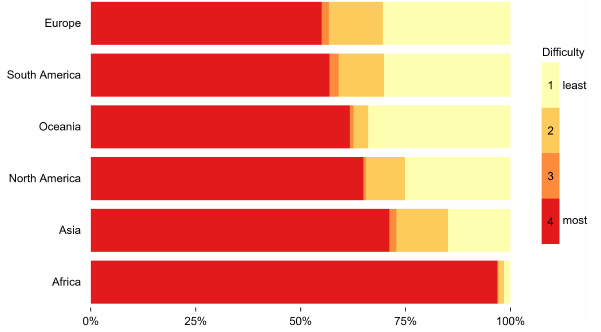
Figure 3. A summary of the difficulties in interpreting SVI by continents. Street view imagery from Europe are the easiest to interpret while those from Africa are the most difficult or they do not provide sufficient